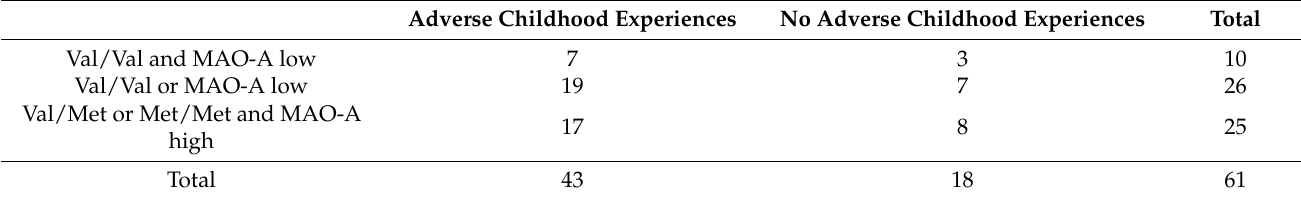
Table 4. Occurrence of the “double risk” genotype Val/Val and MAO-A low, the “single risk” genotype Val/Val or MAO-A low and the “non-risk’ genotype Val/Met or Met/Met and MAOA-A high in the test